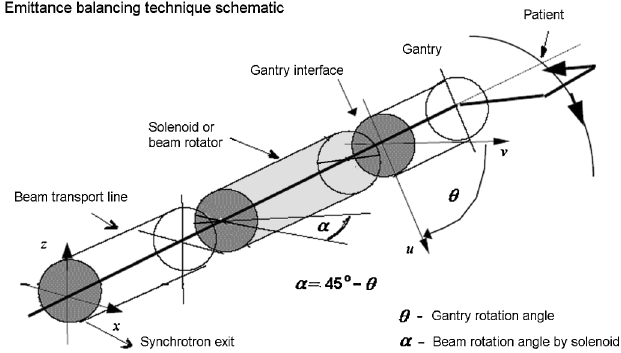
FIG. 3. Schematic for the emittance balancing system matched to a gantry. With a rotator in place, the relation between its rotation angle and the gantry rotation angle should follow Eq.